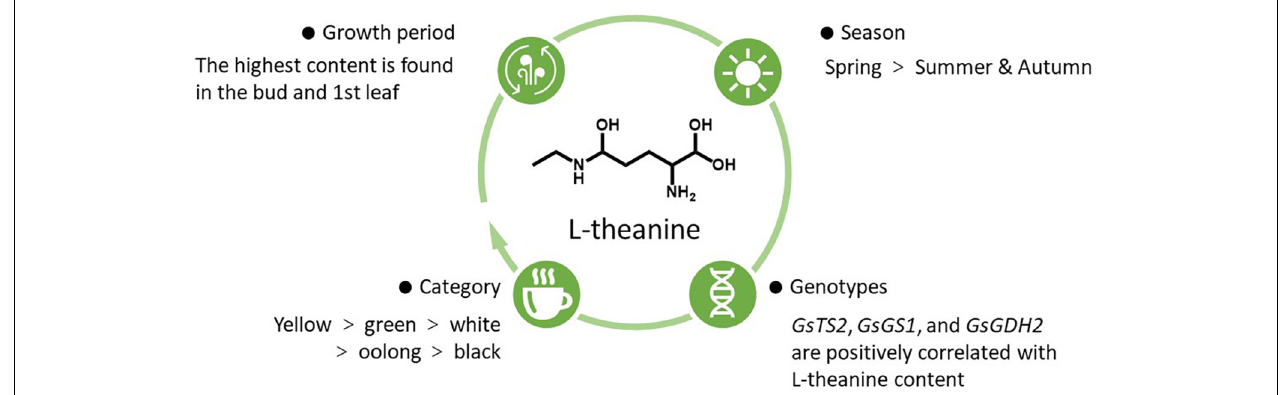
FIGURE 1 | Influencing factors of L-theanine content in tea